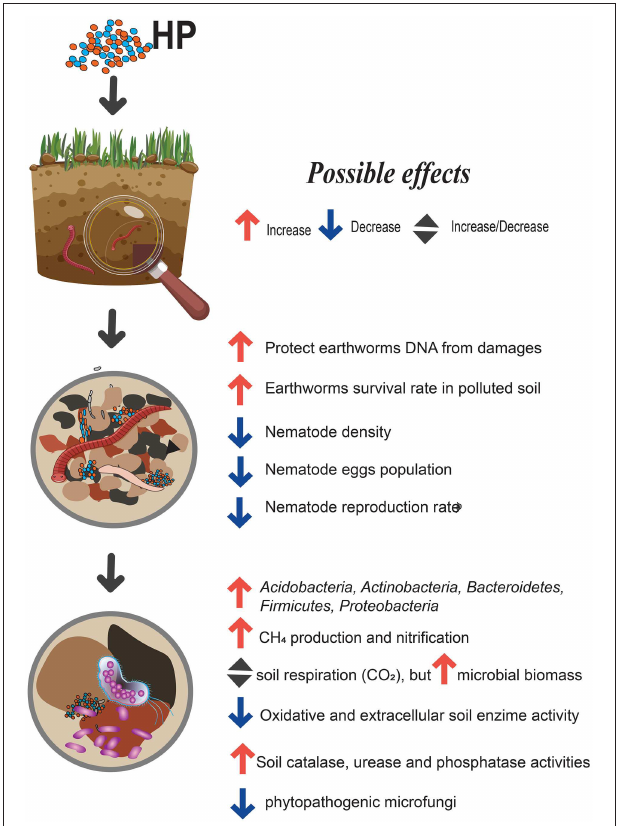
FIGURE 1 | Humic products impact to soil biological